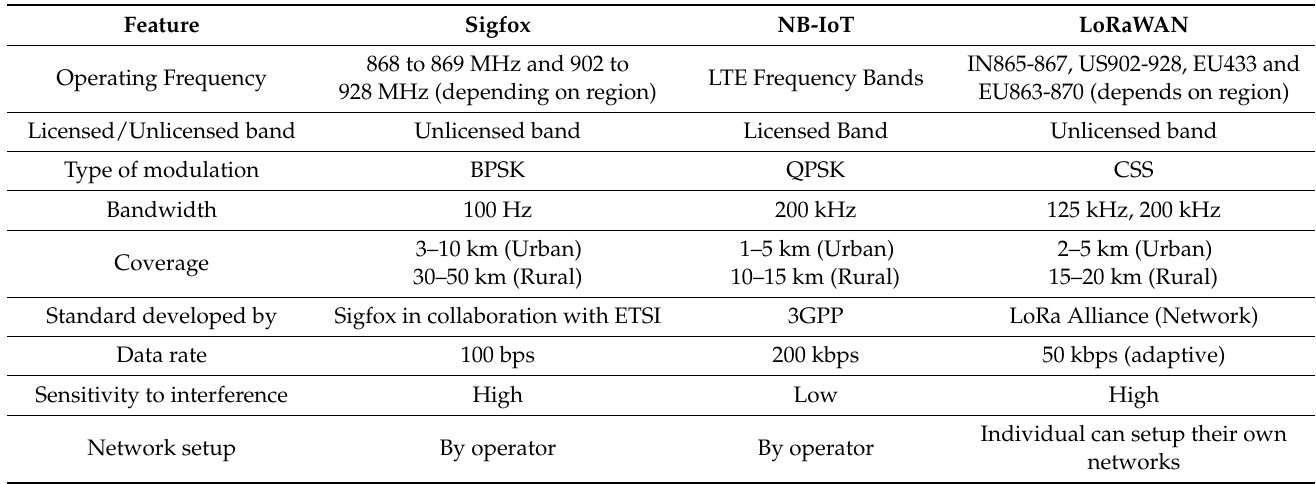
Table 10. Comparison of key parameters of Sigfox, NB-IoT, and LoRa